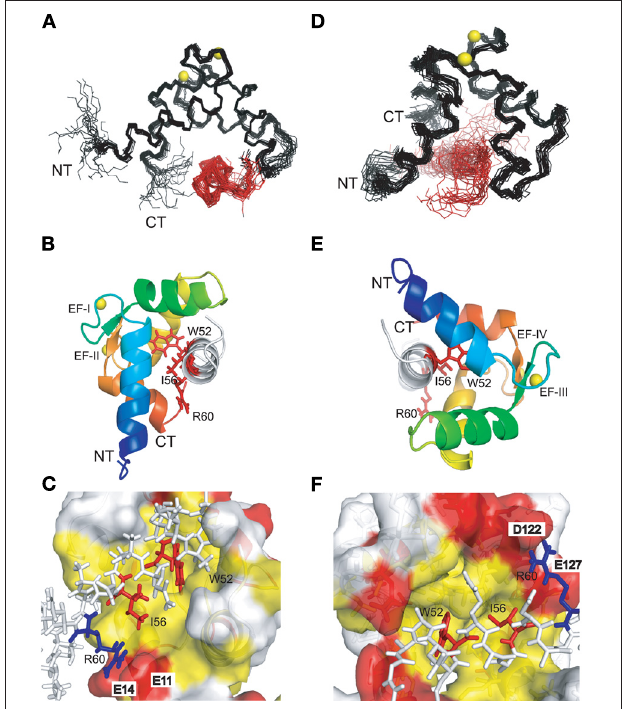
FIGURE 5 | NMR solution structures of the complexes of the N-lobe (A, B, C) and the C-lobe (D, E, F) of Ca 2 + -CaM with the short NSCaTE peptide. (A, D) Backbone representation of the ensemble of the 20 lowest energy structures of the Ca 2 + /CaM-NT-NSCaTE complex ( A , calculated by CYANA2.1) or the Ca 2 + /CaM-CT-NSCaTE complex ( D , generated by HADDOCK). The CaM lobes are shown in black , and the peptide bundles are red . The calcium ions in the EF-hand loop are yellow . The peptide is shown in white , and the three critical residues (W52, I56, and R60) are highlighted in red . (B, E) Ribbon representations of the lowest energy structures for the Ca 2 + /CaM NT (B) and CT (E) complexes. The four helices in each lobe follow the default PyMOL rainbow color setting (blue–green–yellow–orange) from the N-terminus to the C-terminus. (C, F) Binding surface representations of the Ca 2 + /CaM NT (C) and CT (F) complexes. The binding pocket of each lobe is highlighted in yellow (hydrophobic residues) and red (negatively charged residues). The NSCaTE peptide is shown in a stick representation ( white ), and the two critical hydrophobic residues (W52 and I56, red) and the positively charged residue (R60, blue) are